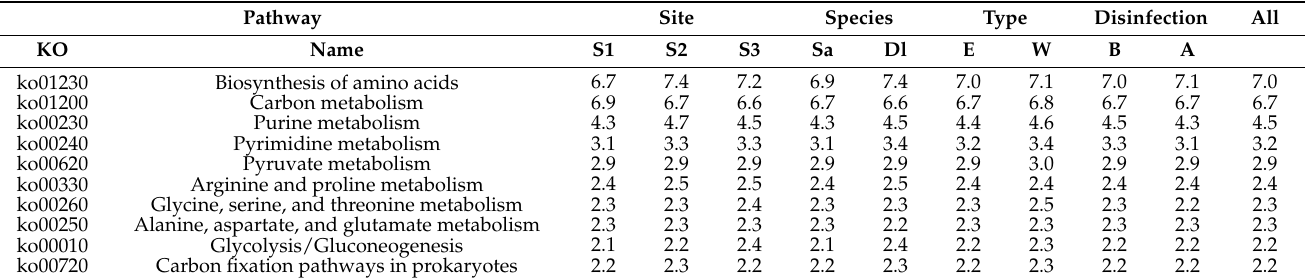
Carbon fixation pathways in prokaryotes